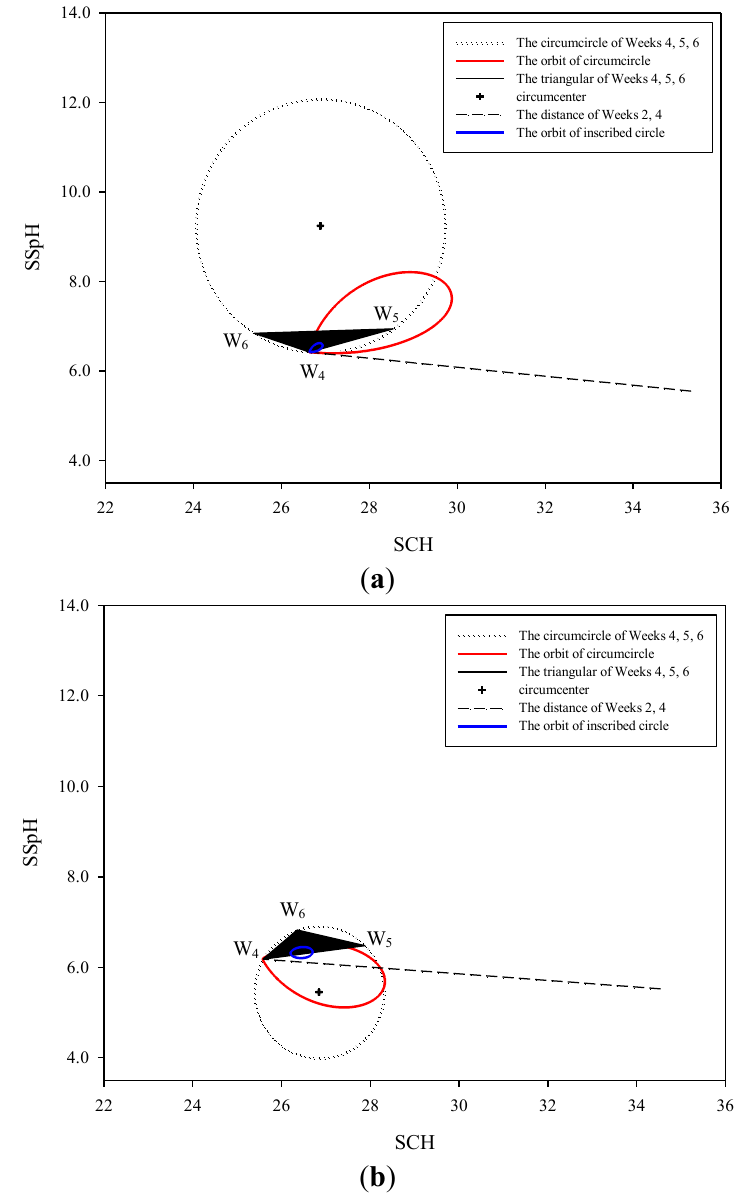
Figure 2. Autonomic nervous system (ANS) performance. ( a ) Left arm. ( b ) Right